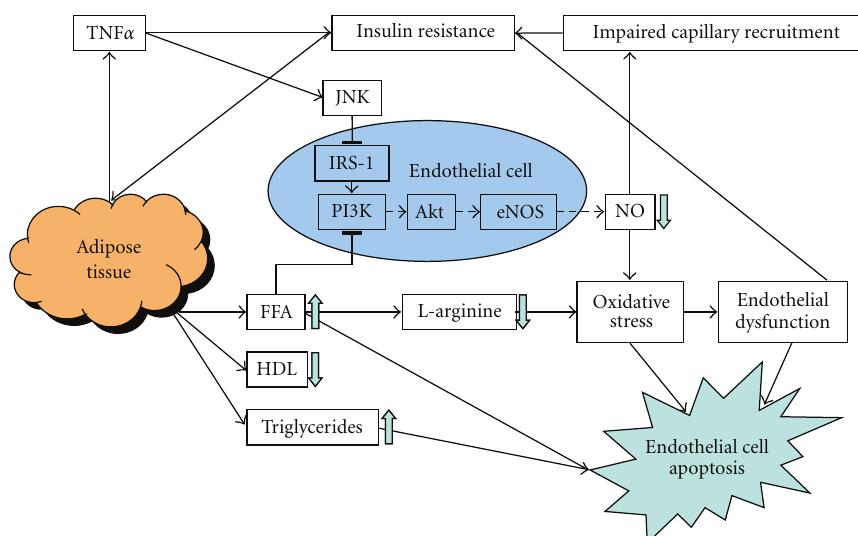
Figure 2: Mechanisms of insulin resistance and adipose tissue in relation to endothelial dysfunction and apoptosis.